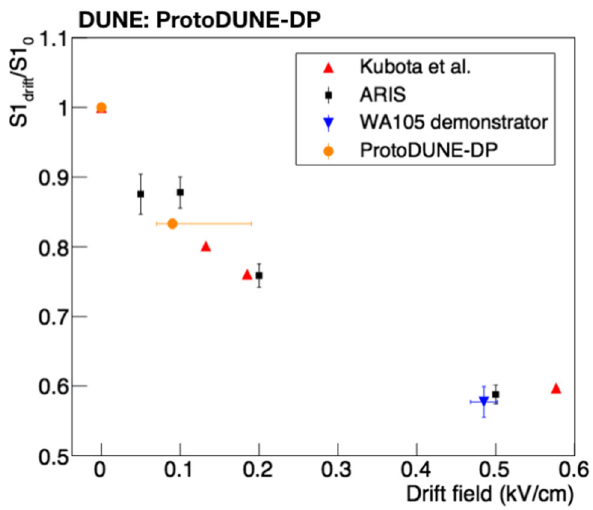
Fig. 18 Light yield reduction with drift field measured by various experiments (red triangles from [49], black squares from [50], blue inverted triangles from [35]), and the ProtoDUNE-DP result (orange circles) discussed in this section